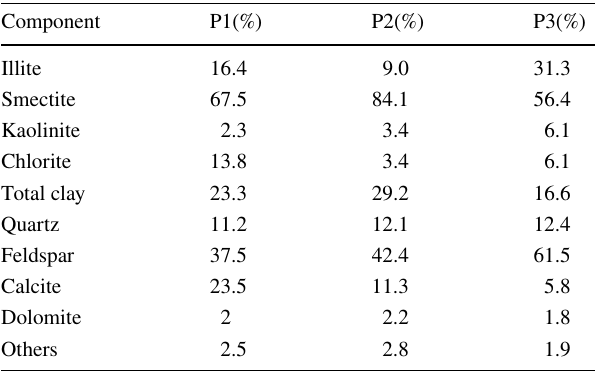
Table 2 Results of XRD mineralogy analysis of core